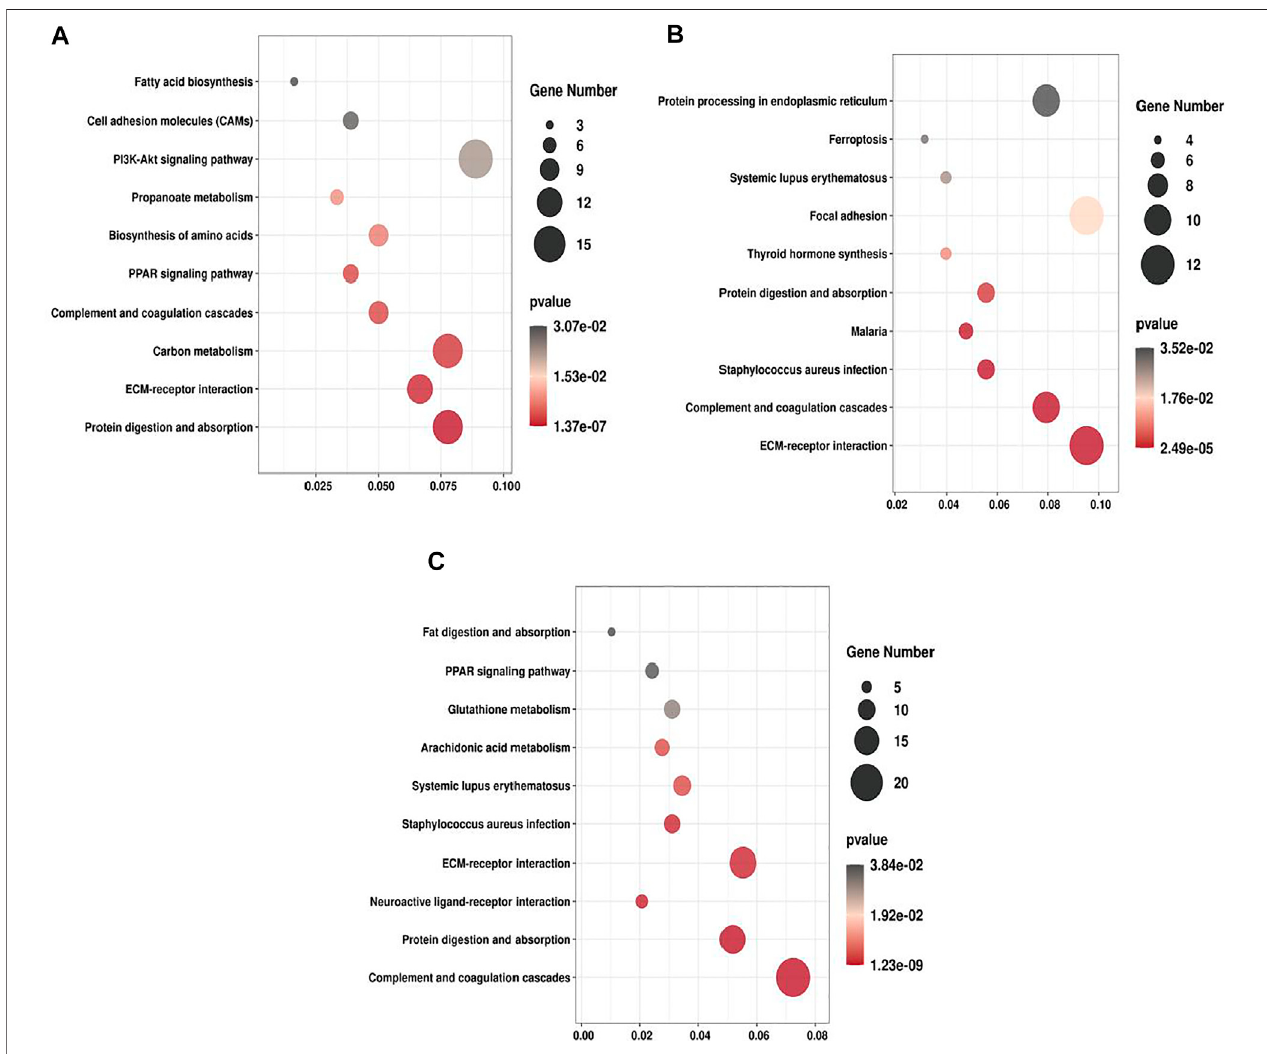
FIGURE 5 | KEGG pathway enrichment of DEPs. (A) T2 VS. T1. (B) T3 VS. T2. (C) T3 VS. T1.